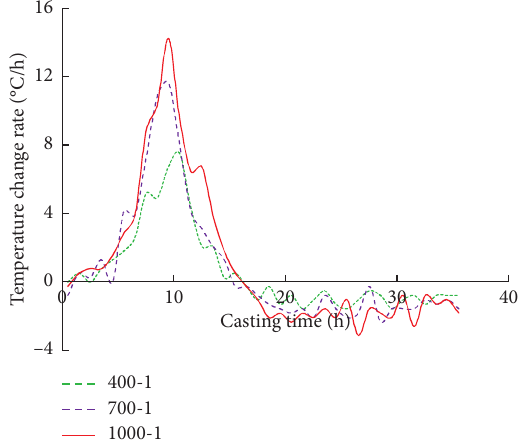
Figure 6: Relationship between the temperature change rate and the casting time (pure cement;